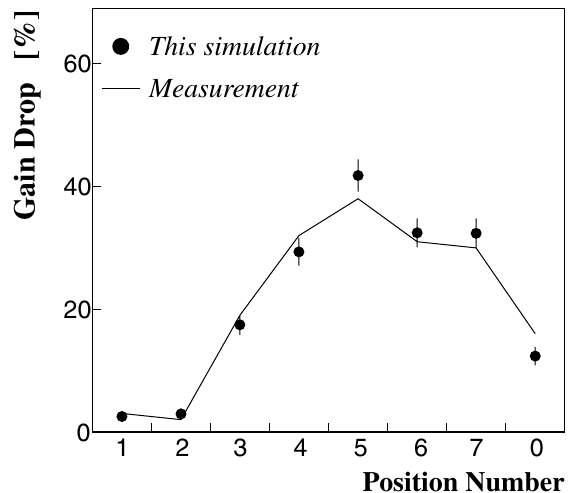
FIG. 7. Comparison between the estimated and measured gain-drop values for period